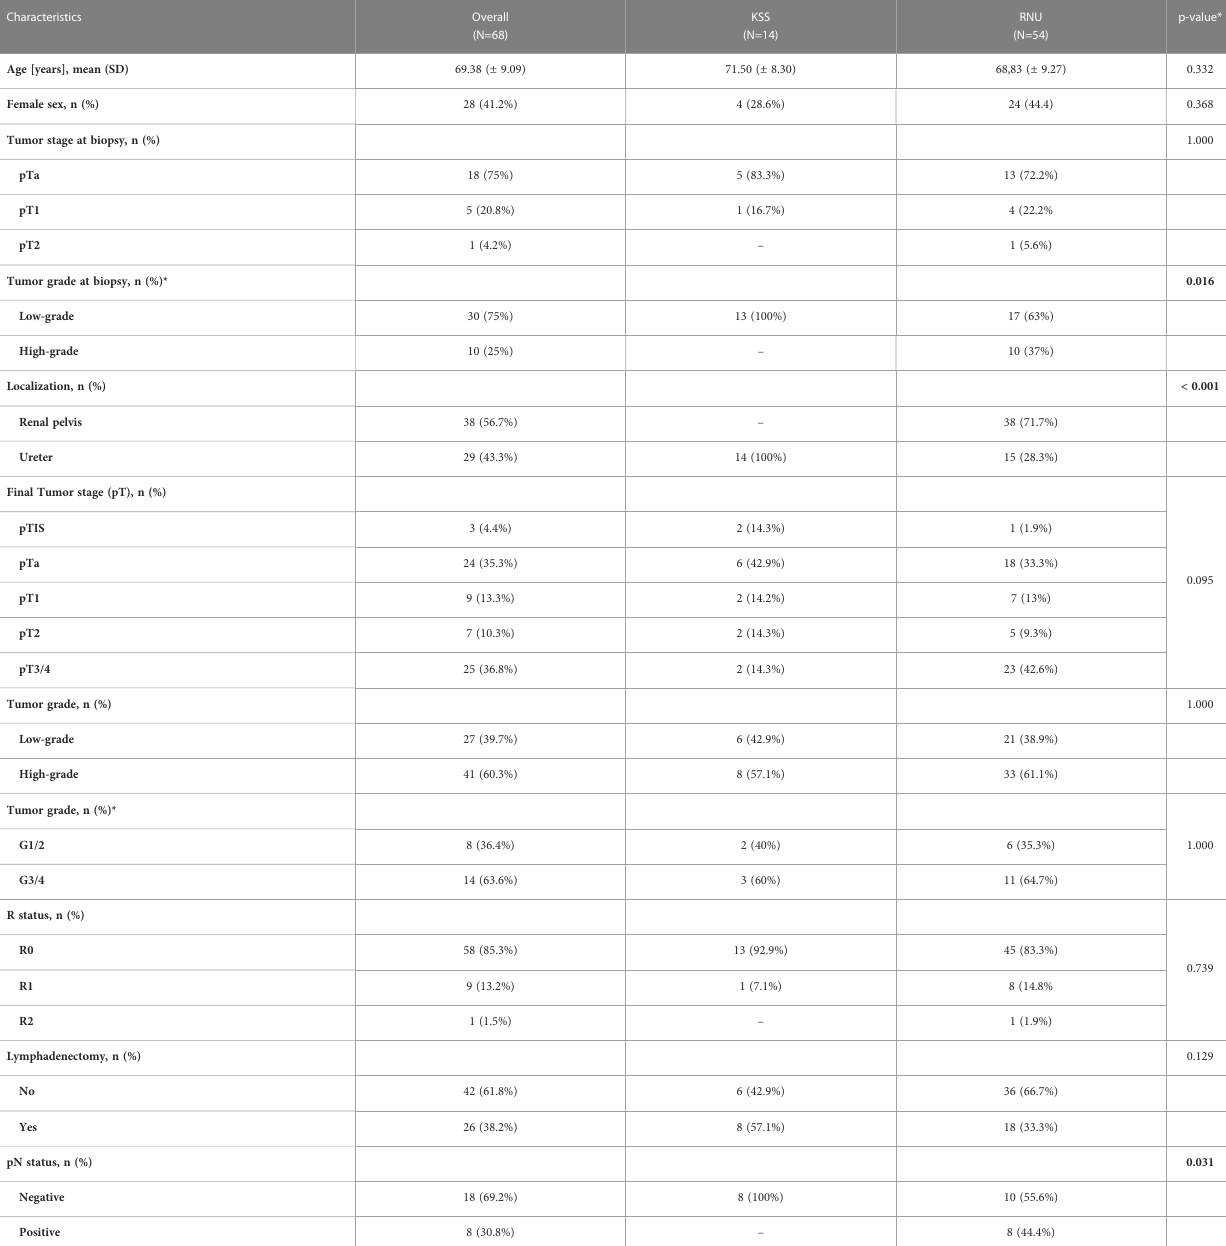
*Findings evaluated for patients with pathological results present. Bold values mean: p <